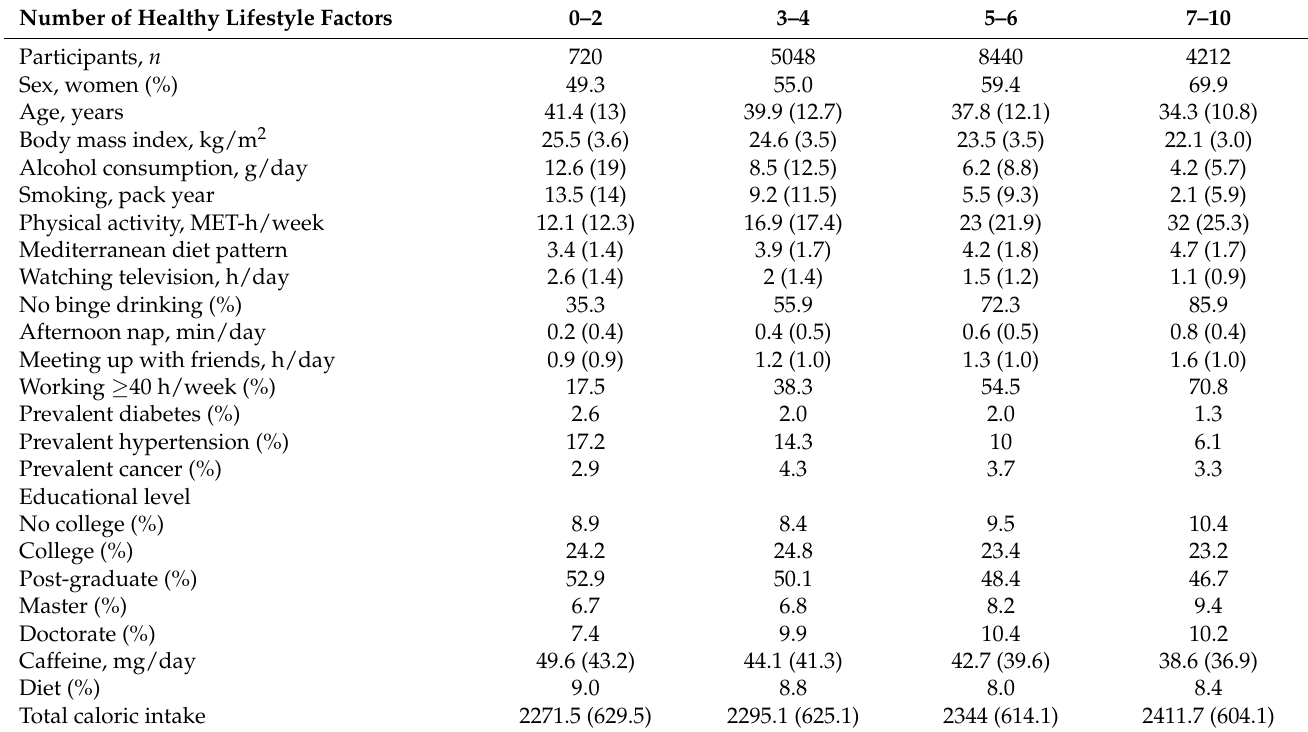
Table 1. Baseline characteristics of participants according to number of healthy lifestyle factors. (The SUN Project).